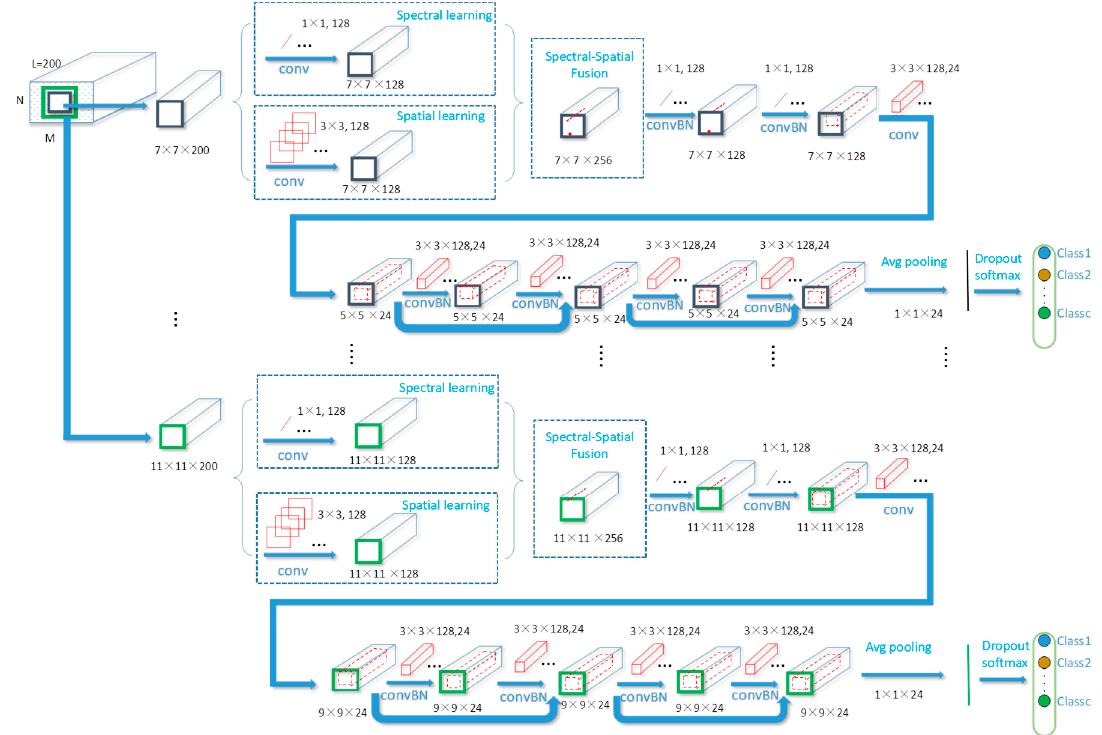
Figure 2. The framework of first training stage in a multiscale deep middle-level feature fusion network (MMFN).